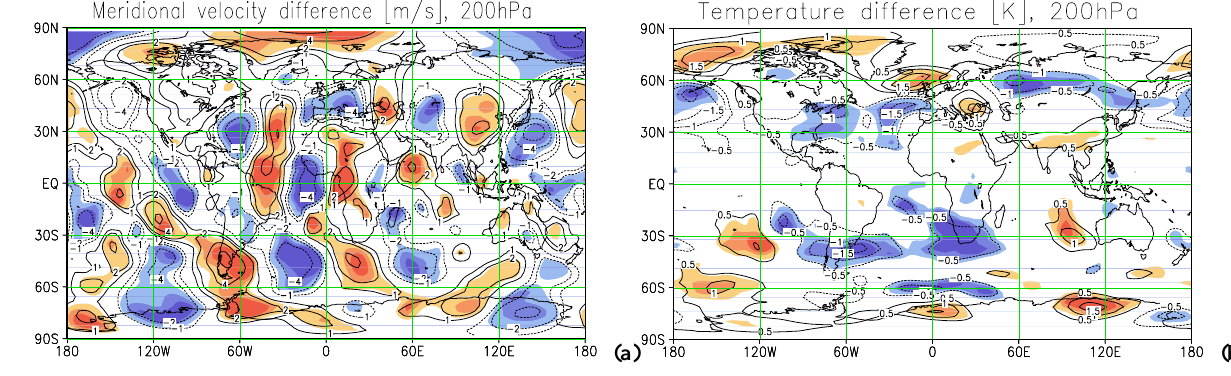
Fig. 4. Meridional wind and temperature response at 200 hPa. Mean meridional wind (a) and temperature (b) response at 200 hPa, regions inside a significance level of 80% (light), 90% (middle) and 95% (dark) are shaded.